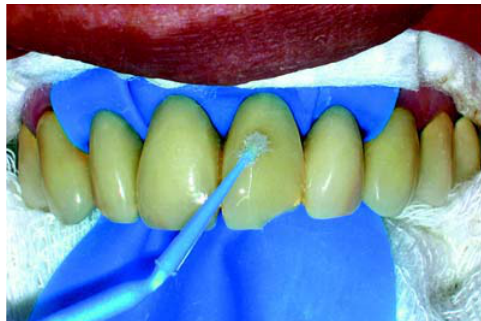
FIGURE 8- Final aspect of the ceramic repair (a and b) FIGURE 4- Application of the silane coupling agent